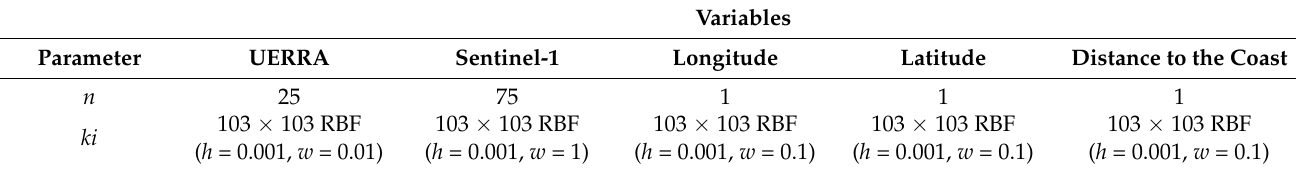
Table 1. Parameters used in QS for each